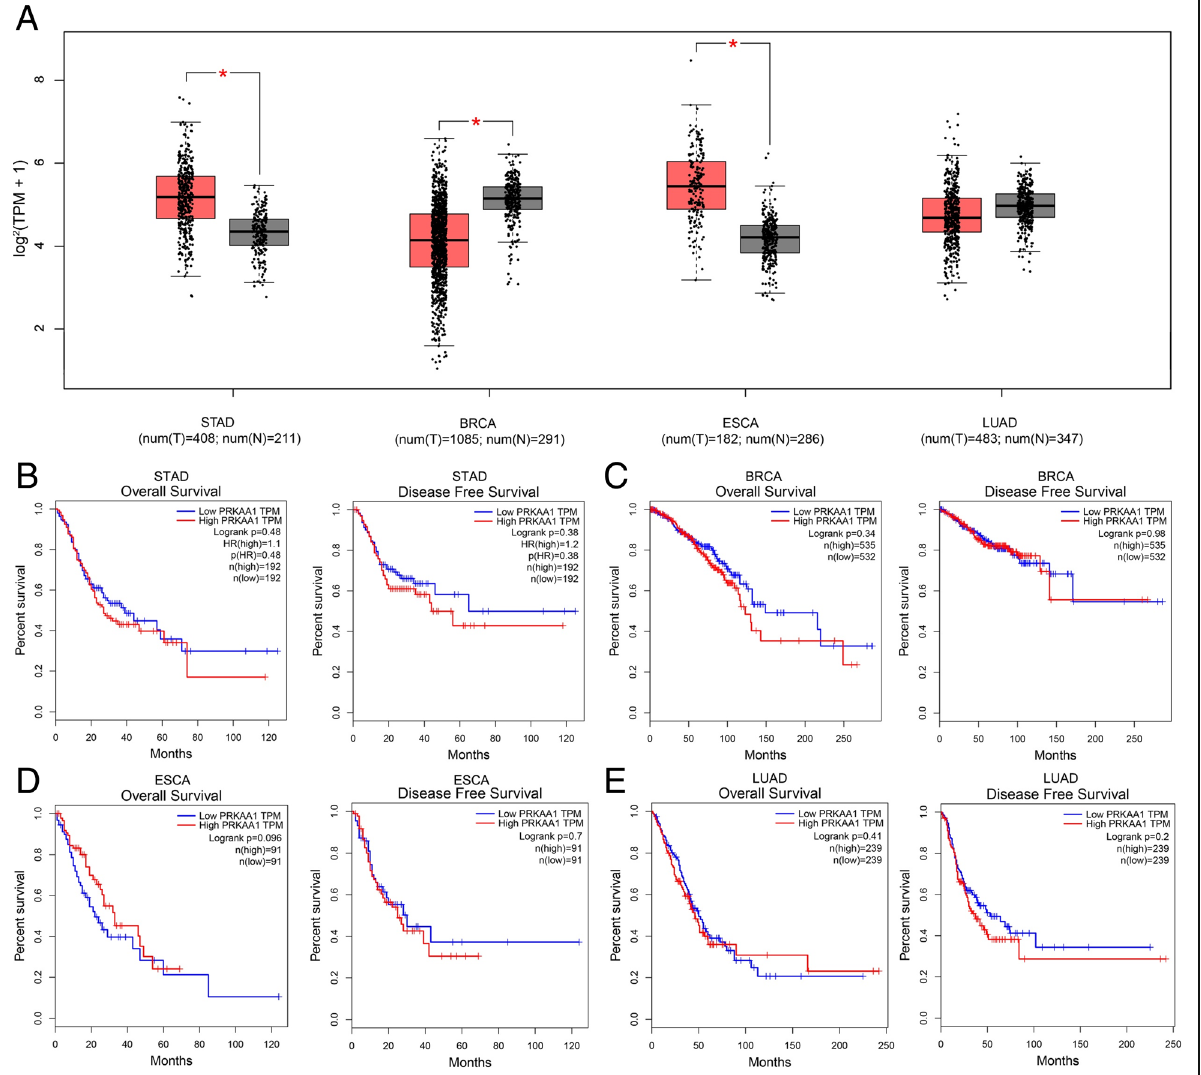
Fig. 5 In-silico analysis of PRKAA1 expression ( a ) The comparison of PRKAA1 expression between tumor site and matched normal tissue from TCGA database. b The correlation between PRKAA1 expression and overall survival time, disease free survival time in stomach adenocarcinoma (STAD). c The correlation between PRKAA1 expression and overall survival time, disease free survival time in breast cancer (BRCA). d The correlation between PRKAA1 expression and overall survival time, disease free survival time in esophageal carcinoma (ESCA). e The correlation between PRKAA1 expression and overall survival time, disease free survival time in lung adenocarcinoma